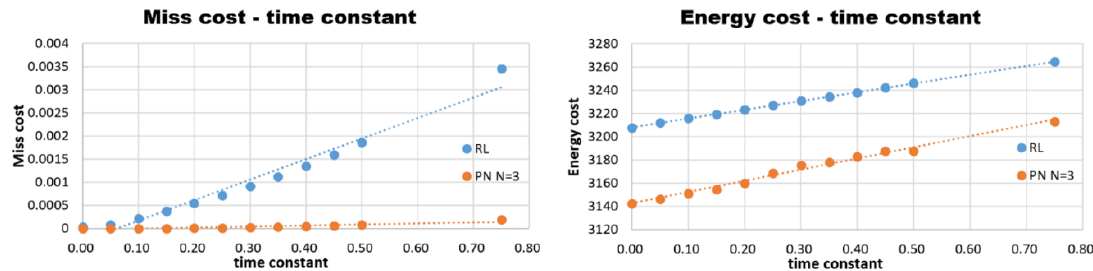
Figure 14. Cost trend for various 𝜏 (N = 3)